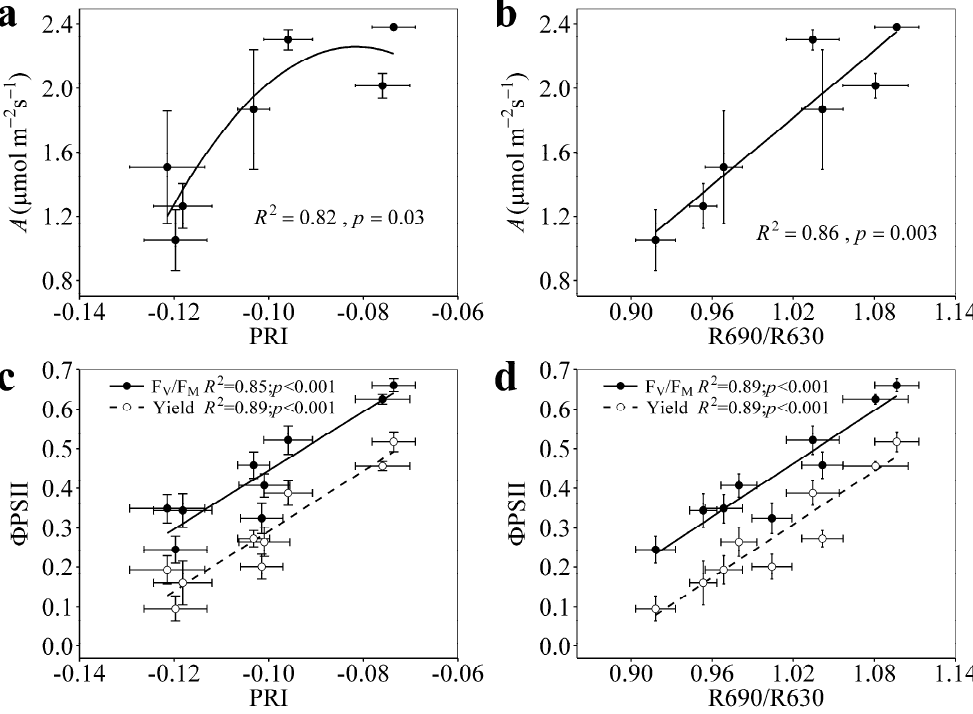
Figure 2. Relationships of A with PRI ( a ) and R690/R630 ( b ), and photochemical efficiency of PSII ( Φ PSII) (F V /F M and Yield) with PRI ( c ) and R690/R630 ( d ) for Quercus ilex . All the values are from Figure 1.